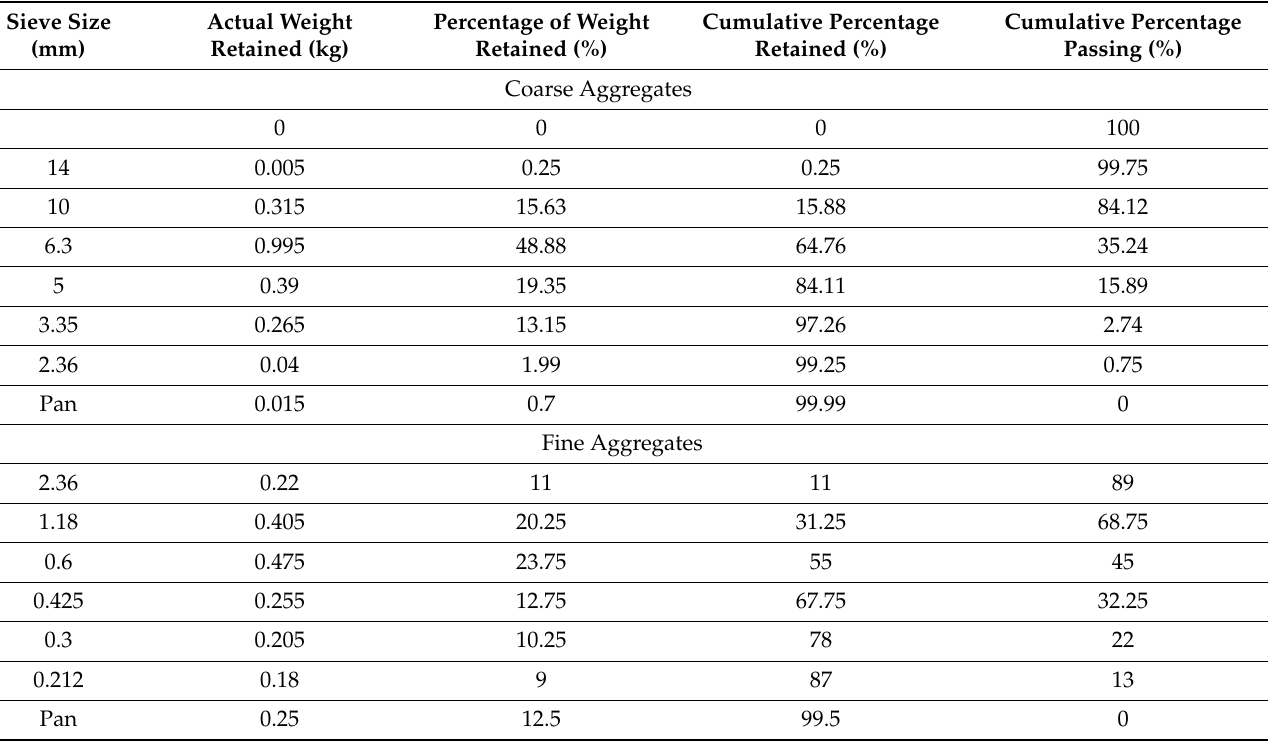
Table A1. Aggregate gradation of coarse and fine aggregates.